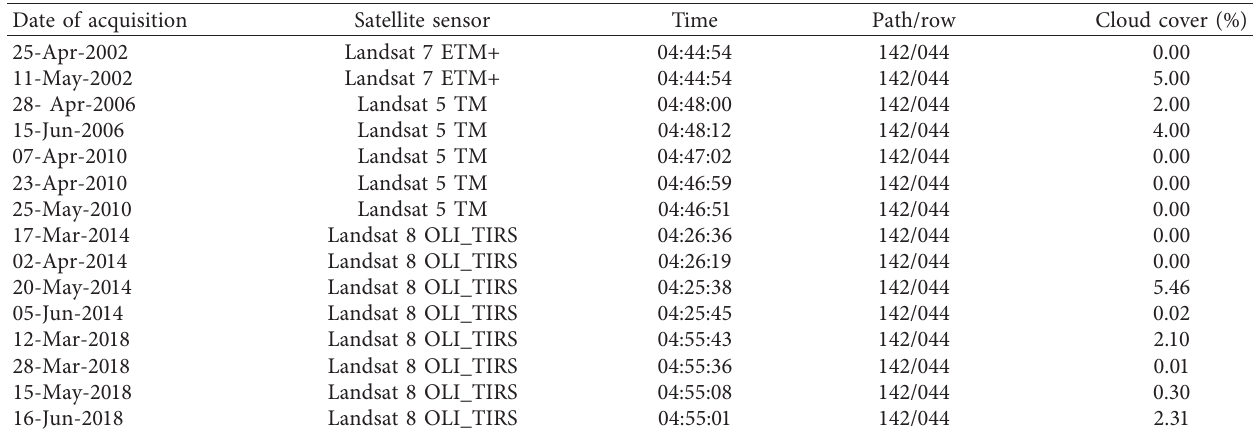
Table 1: Description of Landsat data from different